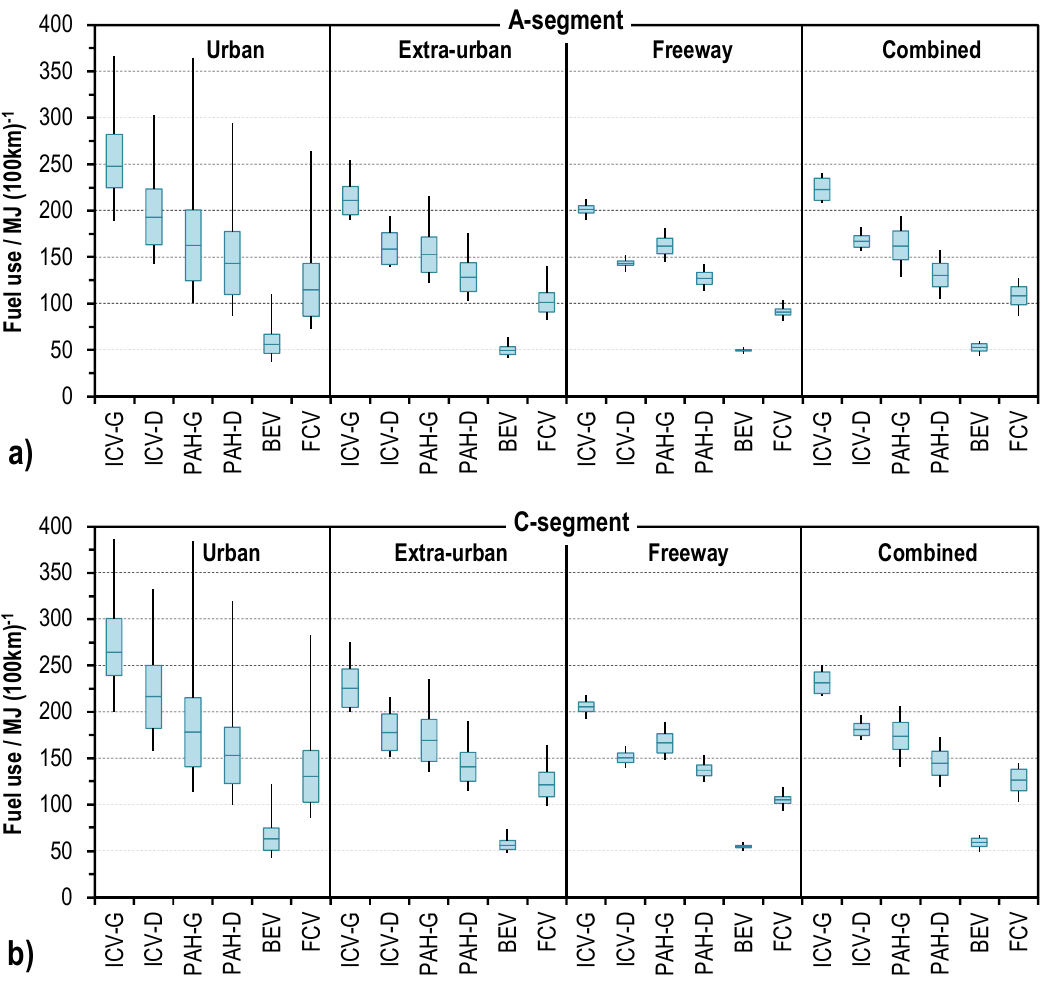
Figure A1. Results of fuel economy analysis for all concepts and onboard load cases related to the “standard” scenario, for ( a ) A-segment and ( b ) C-segment cars. Values are displayed as box plots related to the cycle groups of urban, extra-urban, freeway and combined with (from below): minimum, third quartile, median, first quartile and maximum.